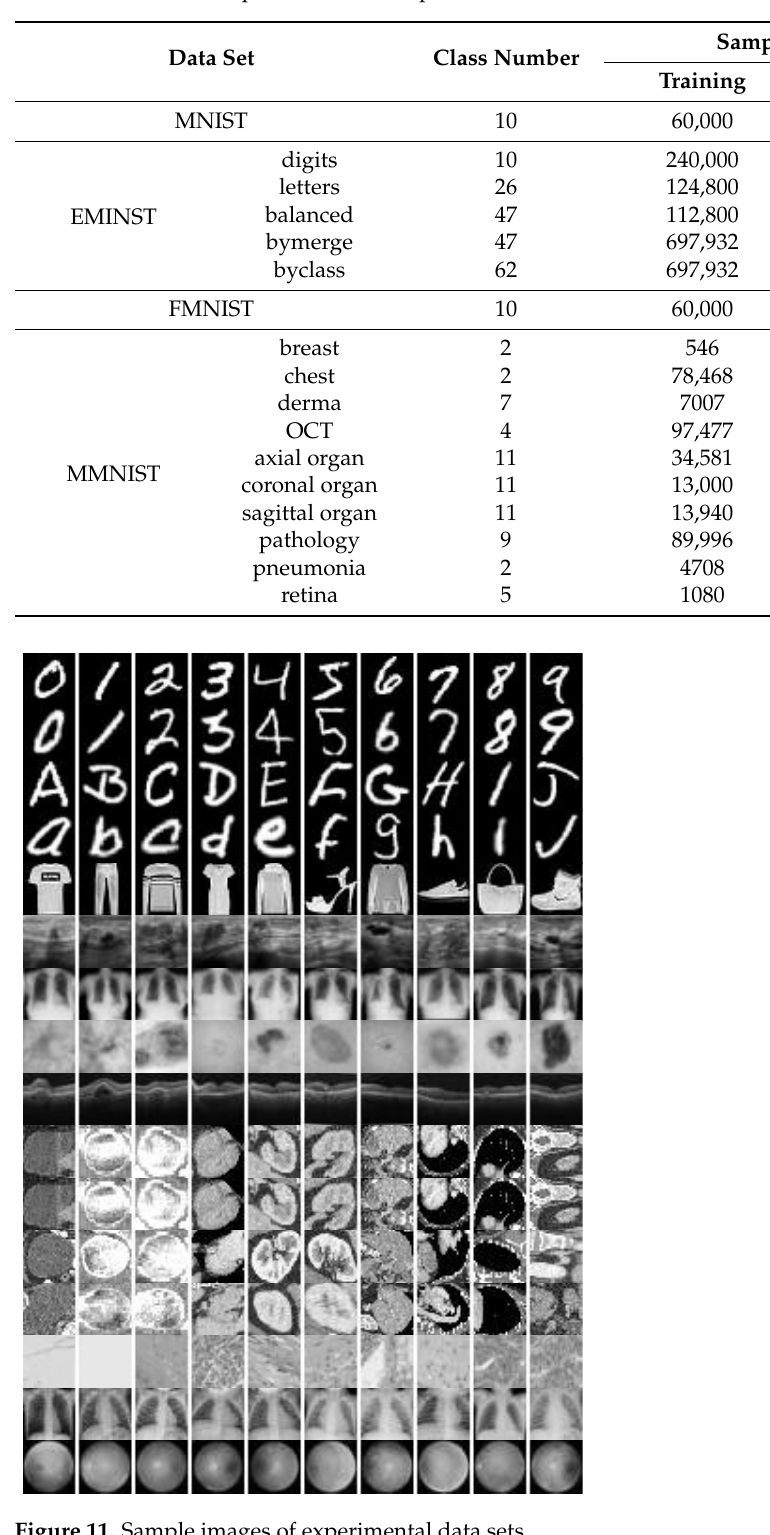
Table 3. Class and sample numbers of experimental data sets.